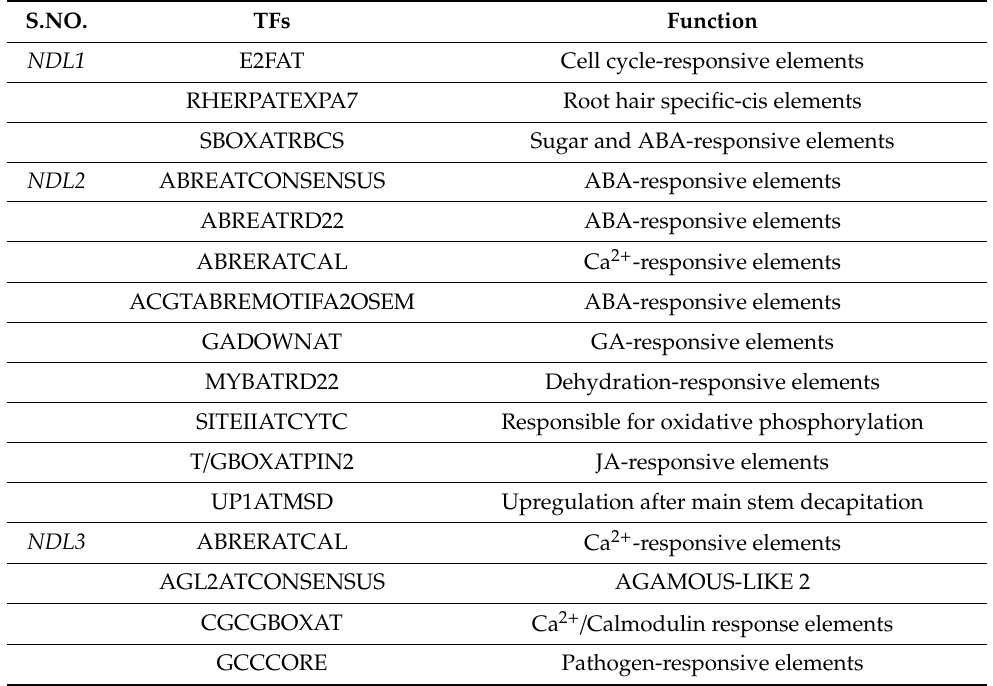
Table 2. List of specific TFs binding sites in promoter region of NDL1 , NDL2 , and NDL3 .